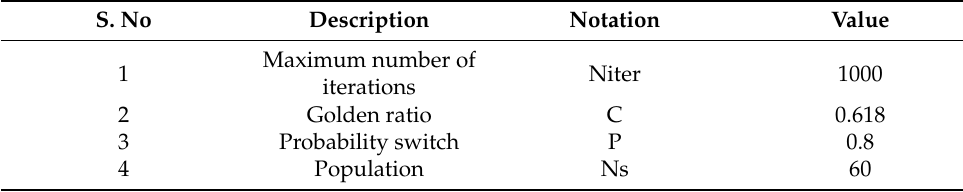
Table 3. Implementation parameters of the proposed algorithm.